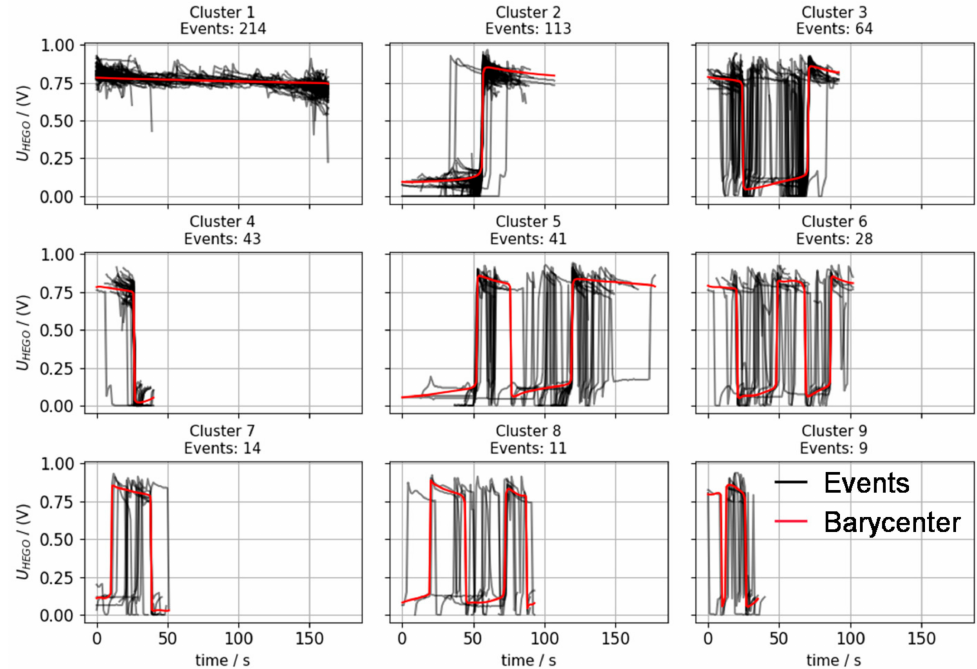
Figure 8. Extract of identified clusters for the downstream lambda sensor voltage for 842 NO X